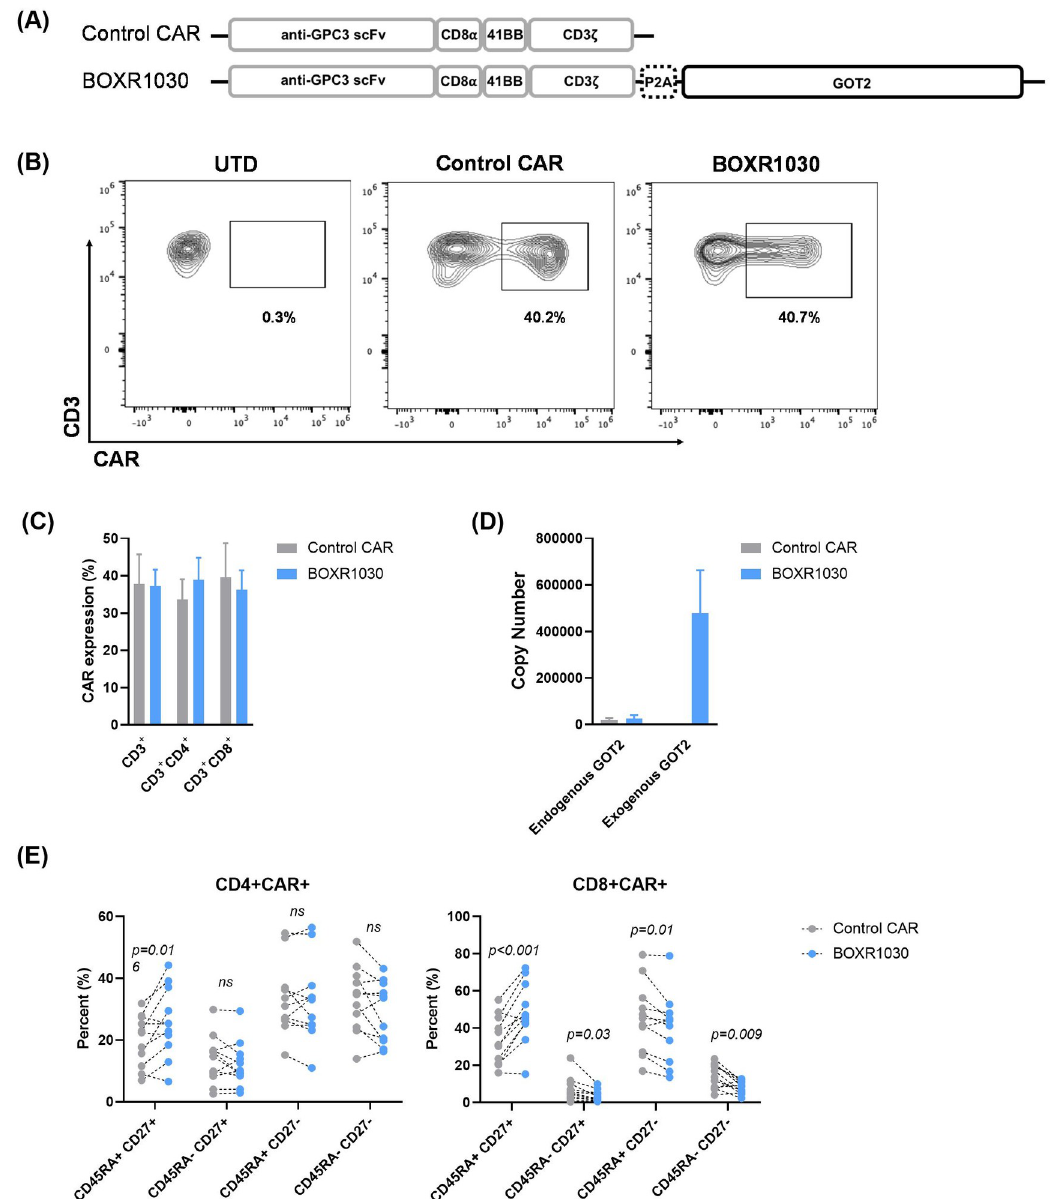
Fig 2. Co-expression of GPC3-targeted CAR with exogenous GOT2 in BOXR1030 T cells. (A) Depiction of expression construct and domains for the GPC3 CAR and BOXR1030 used in studies. (B) Representative surface expression of the anti-GPC3 scFv following transduction, measured on day 9 by flow cytometry from a single donor. (C) Summarized CAR expression by flow cytometry for n = 5 healthy donors. (D) mRNA copy number of endogenous and exogenous (codon optimized) GOT2 measured by qPCR (n = 3 donors). (E) The frequency of CD45RA+ CD27+, CD45RA+ CD27-, CD45RA- CD27+, and CD45RA- CD27- T cells in the indicated subsets at baseline (n = 11 healthy donors; no stimulation). P-values were determined by paired t-test. Data represented as mean+/- standard deviation